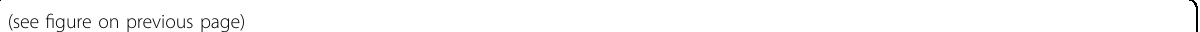
Fig. 1 Schematic representation of the chip-based total internal re fl ection fl uorescence microscopy (chip-TIRFM) setup. a Working principle of chip-TIRFM: upon coupling onto the input facet, the excitation light propagates through the waveguide core material due to total internal re fl ection. An evanescent fi eld of ~150 nm height excites a thin layer of fl uorescent dyes in the vicinity of the photonic chip surface, allowing for TIRFM imaging. b Top view of a photonic chip containing ultrathin Tokuyasu cryosections covered with a 1:1 cryoprotectant mixture of 2.3 M sucrose and 2% methylcellulose, and surrounded by a custom-made transparent polydimethylsiloxane (PDMS) frame. The inset illustrates the various strip waveguide widths available on the chip. c The chip-TIRFM setup is composed of a custom-made photonic chip module and a commercially available upright collection module. Upon coupling the excitation light on the photonic chip, the fl uorescent signal is allowed through a fi lter set and captured with a scienti fi c CMOS camera. d The photonic chip allows decoupling of the excitation and the collection light paths, enabling TIRFM imaging using conventional microscope objectives. Different wavelengths propagating on the waveguide core allow for multicolor TIRFM imaging. e TIRFM images of a 100 nm thick pig heart cryosection imaged on a photonic chip through different microscope objectives. Membranes in magenta and nuclei in cyan. Supplementary Information S9 provides a detailed view and an extended description of this tissue sample. f Magni fi ed view of